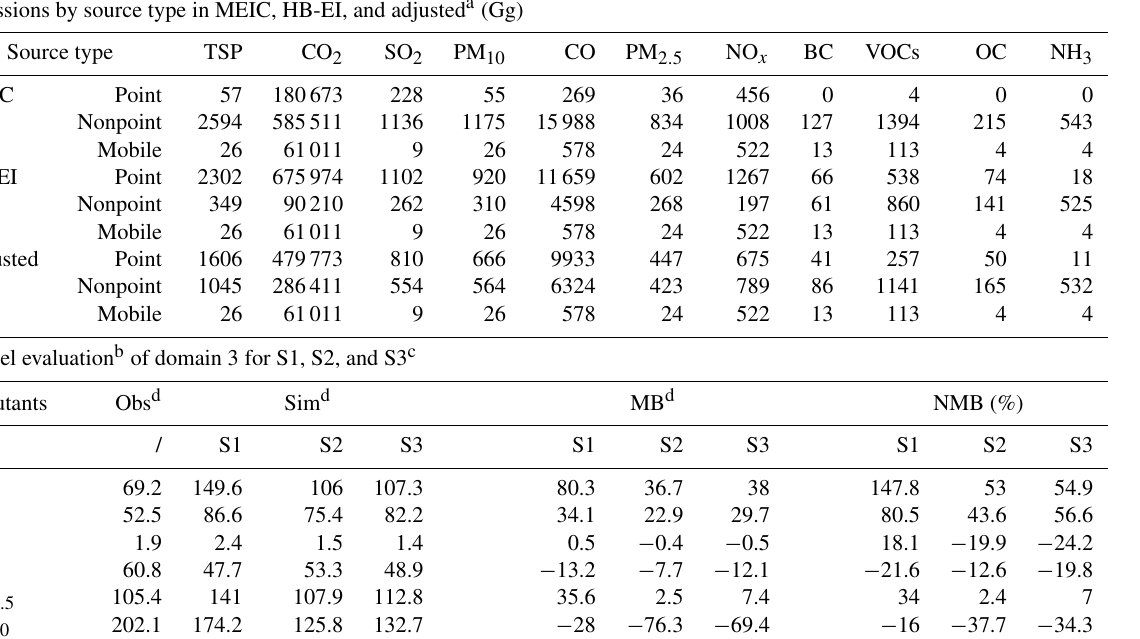
Table 3. Sensitivity analysis